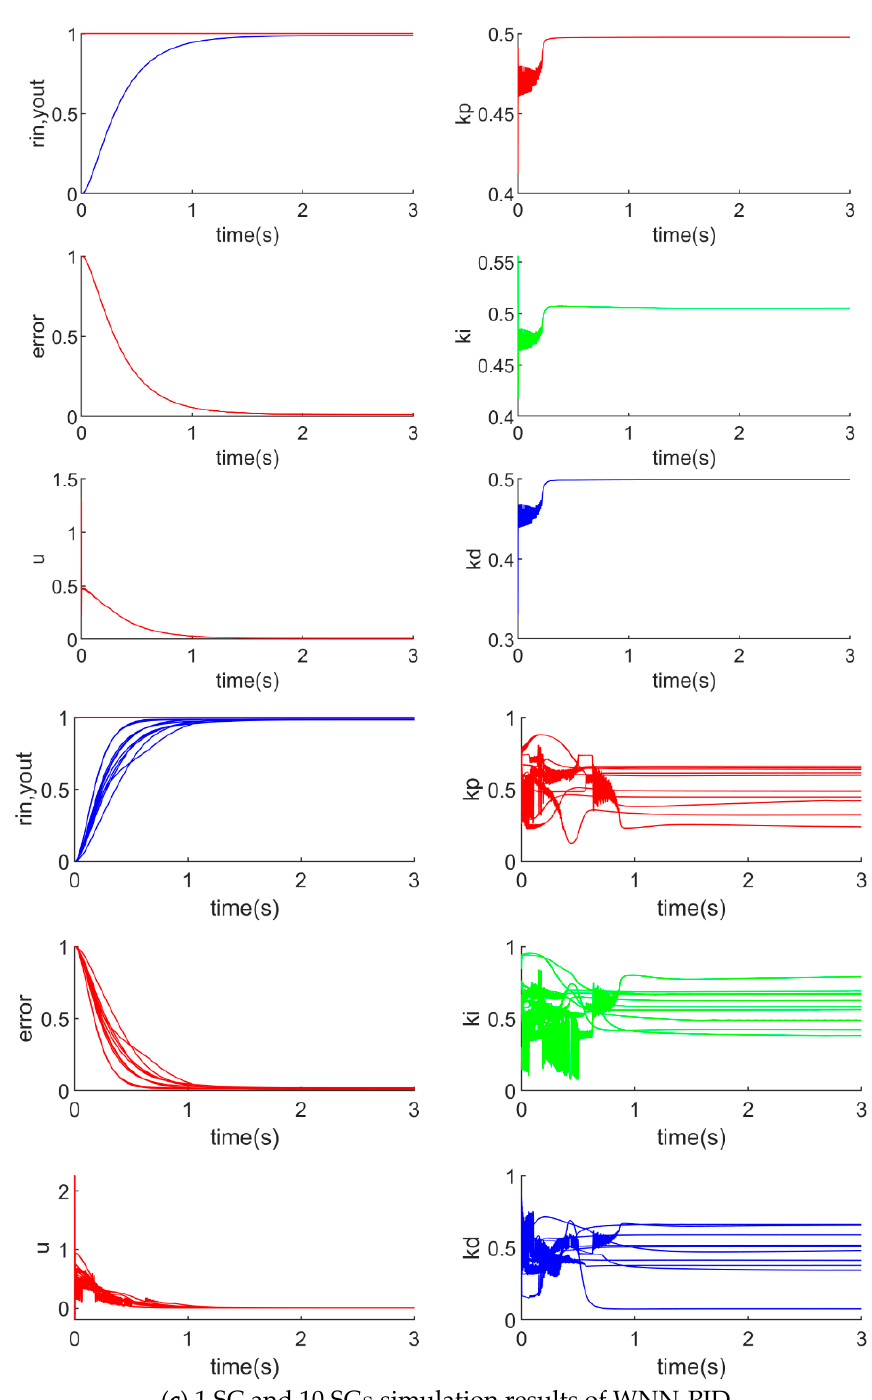
Figure 9. 1 SC and 10 SCs simulations for each algorithm: ( a ) 1 SC and 10 SCs simulation results of BPNN-PID; ( b ) 1 SC and 10 SCs simulation results of RBFNN-PID; ( c ) 1 SC and 10 SCs simulation results of WNN-PID.